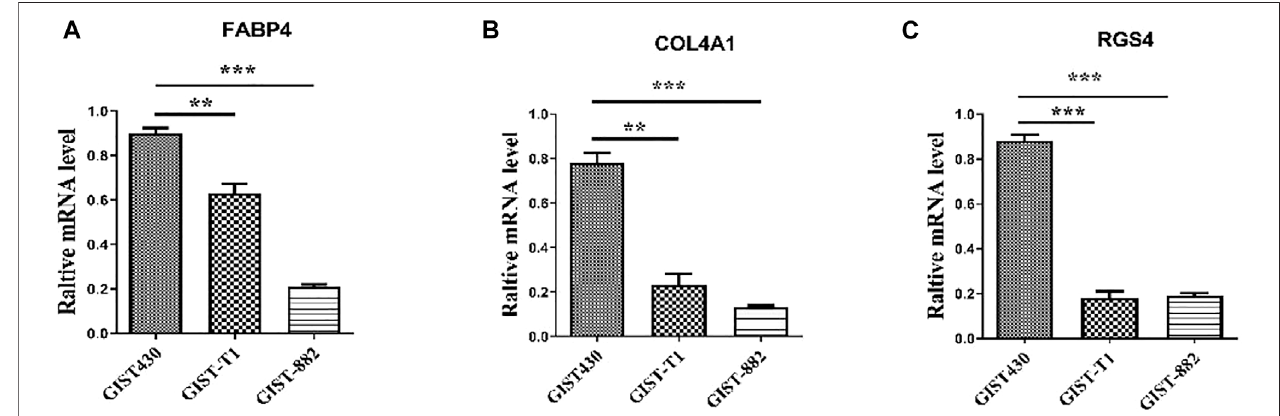
FIGURE 5 | Expression levels of FABP4, COL4A1, and RGS4 in different GIST cell lines determined using quantitative real-time polymerase chain reaction. “ ** ” means p -value < 0.01, “ *** ” means p -value < 0.001.